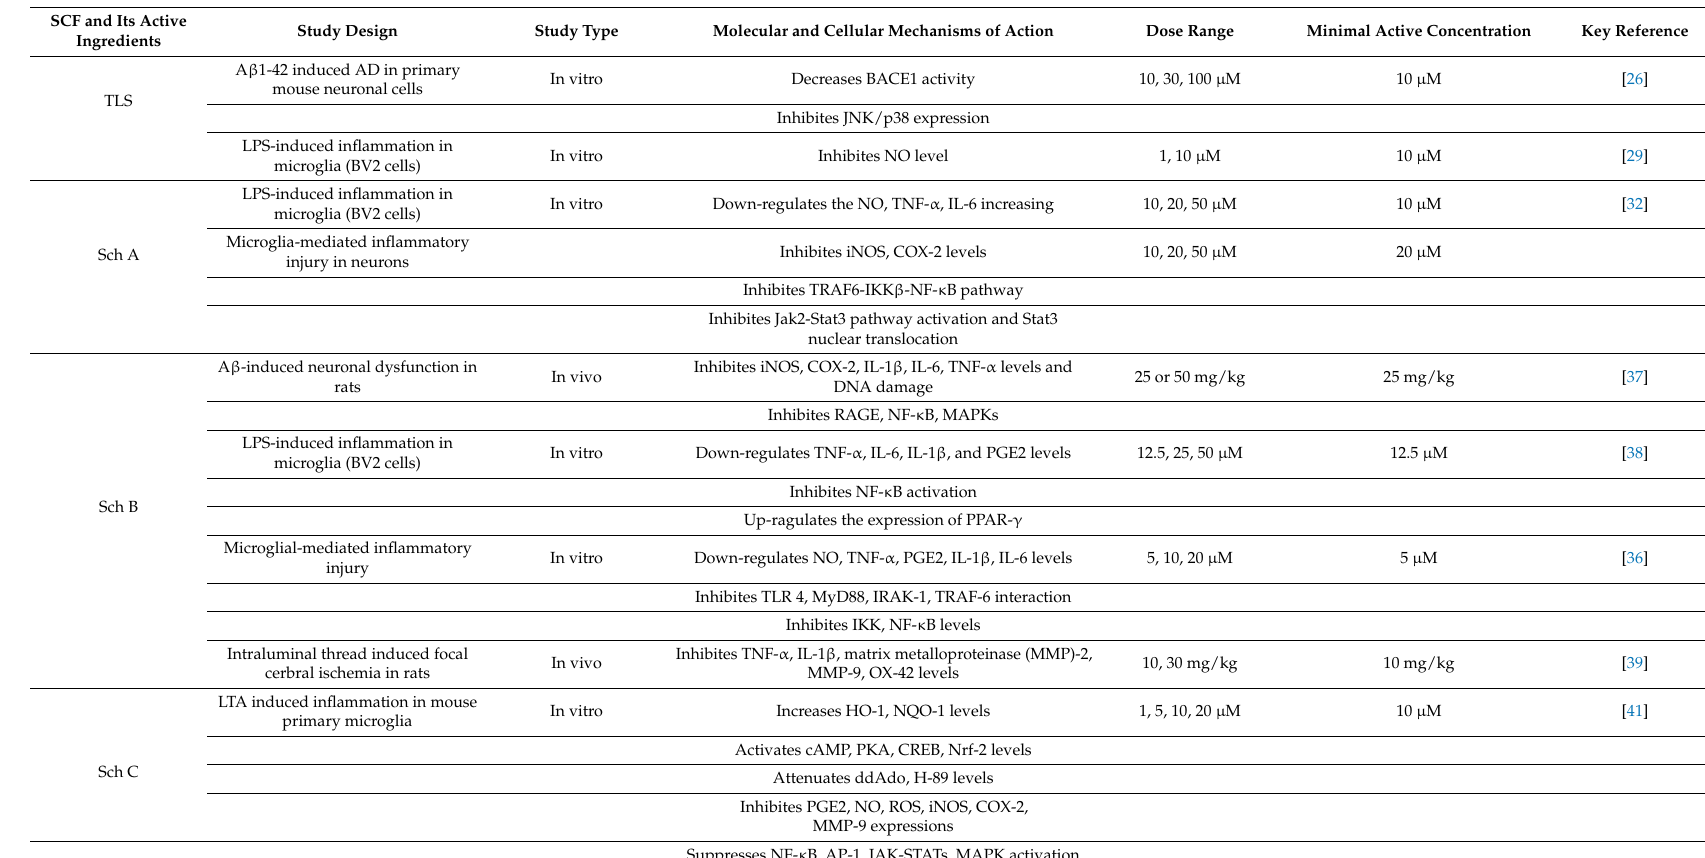
Table 4. The pharmacological data of SCF and its active ingredients in protecting against NDs by anti-inflammation